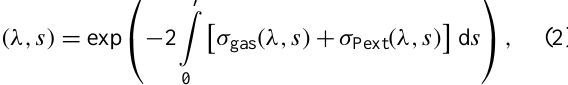
Figure 1. Typical atmospheric transmittance due to gases (top) and hydrometeors (middle) (Eq. 2) for a surface return journey (down- ward atmospheric pass, surface reflection, upward pass) for a nim- bostratus cloud near the 60GHz O 2 band region. (bottom) Ocean backscatter for a surface wind of 3ms − 1 and temperature of 28 ◦ C. Note that only the transmittance due to gases (top) show a signifi- cant frequency